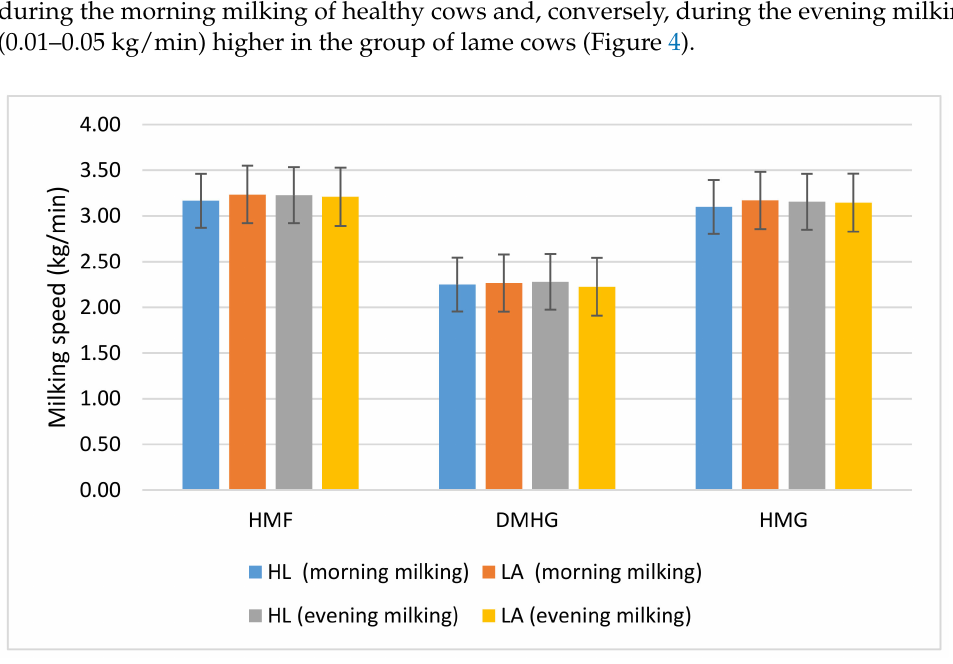
Figure 4. Milking speed traits (kg/min) of cows by